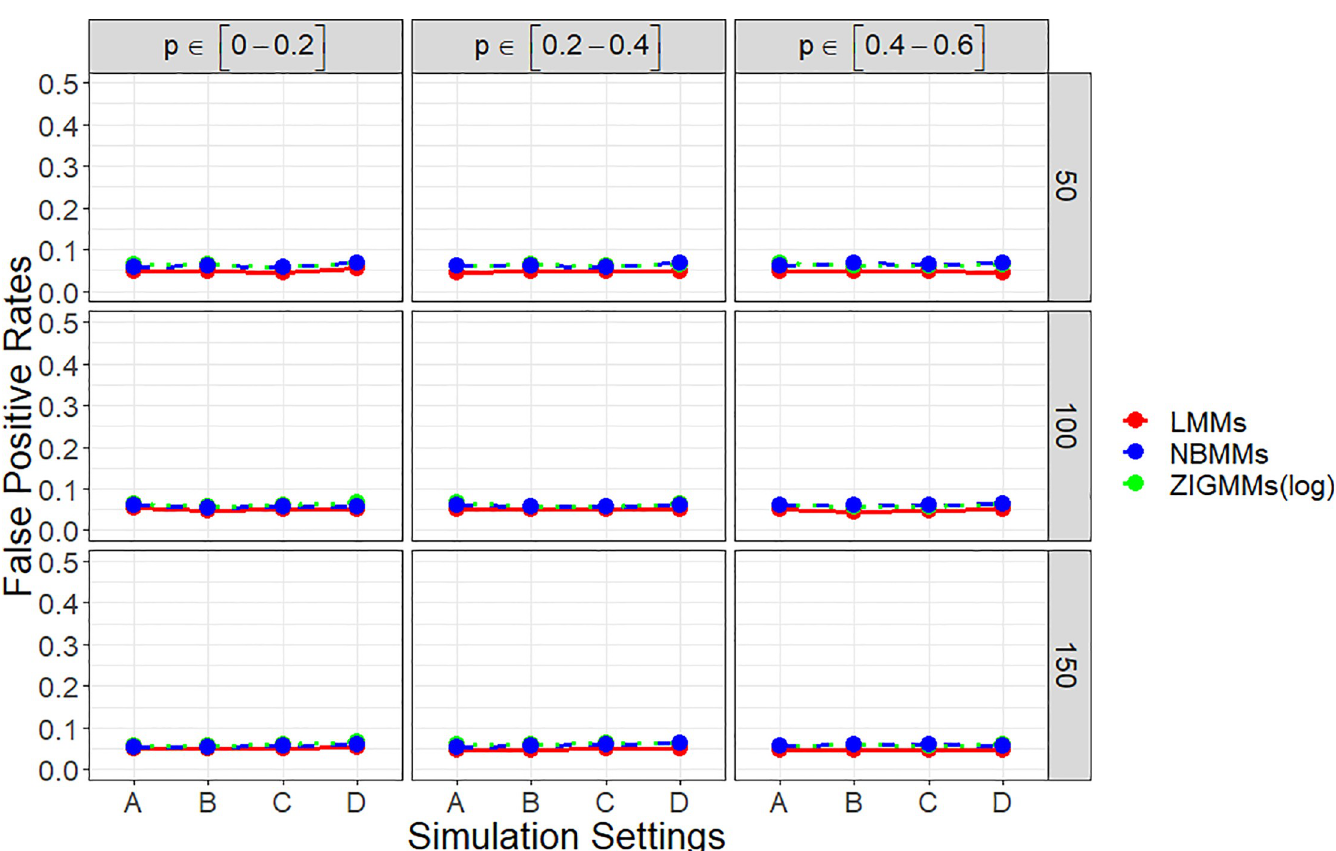
Fig 2. False positive rates in all four simulation